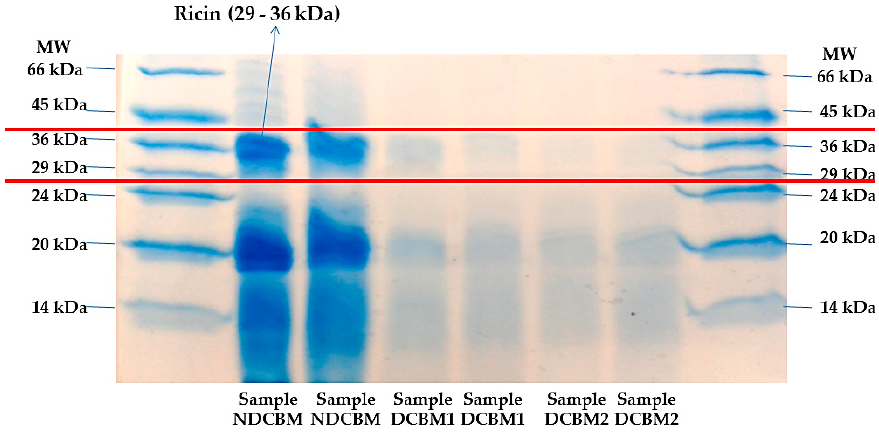
Figure 1. Gel stained with Coomassie brilliant blue. MW, Molecular weight; NDCBM, Non-DCBM; DCBM1, Sample 1 of DCBM; DCBM2, Sample 2 of DCBM.